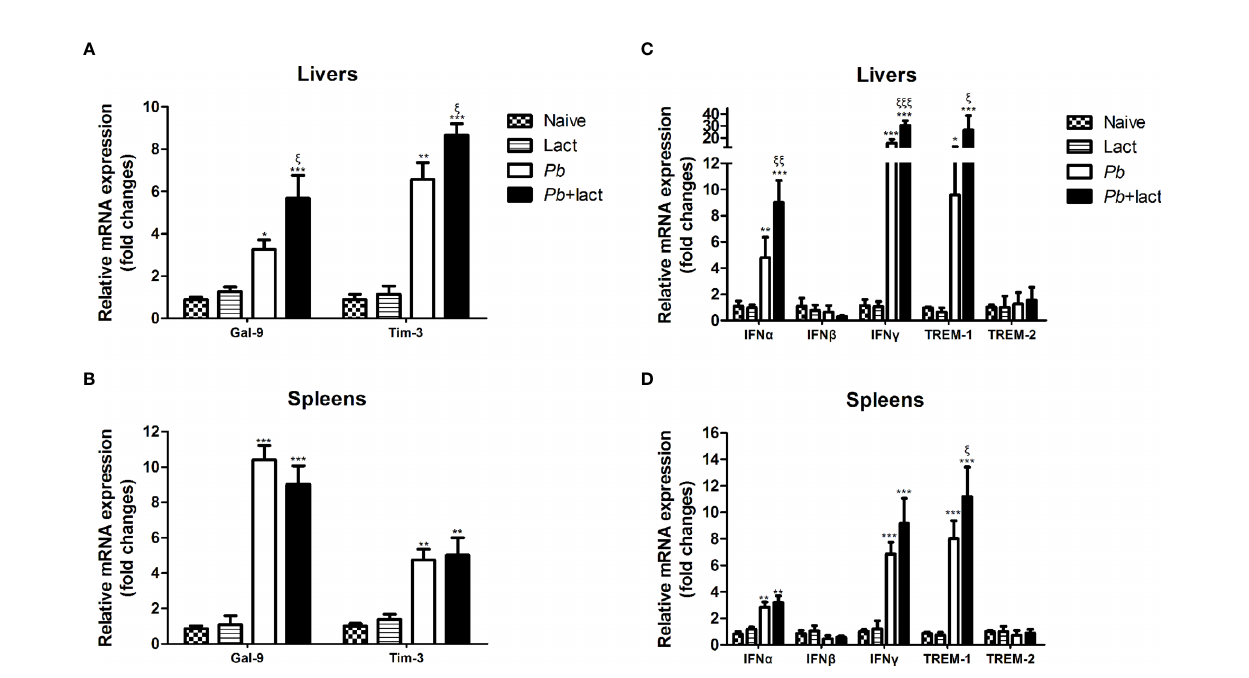
FIGURE 6 | Relative mRNA expressions of Gal-9, Tim-3, IFN a , IFN b , IFN g , TREM-1, and TREM-2 in the liver (A, C) and spleen (B, D) tissues of Pb ANKA-infected mice with or without a -lactose treatment were detected by using qRT-PCR. Values are means from triplicate measurements, and data are presented as means ± SD; two independent experiments were performed with 4 mice per group. * P < 0.05, ** P < 0.01, and *** P < 0.001, a -lactose-control, malarial mice on day 7 p.i., and malarial mice with a -lactose treatment on day 7 p.i. vs . naive mice; x P < 0.05, xx P < 0.01, and xxx P < 0.001, malarial mice with a -lactose treatment on day 7 p.i. vs . malarial mice on day 7